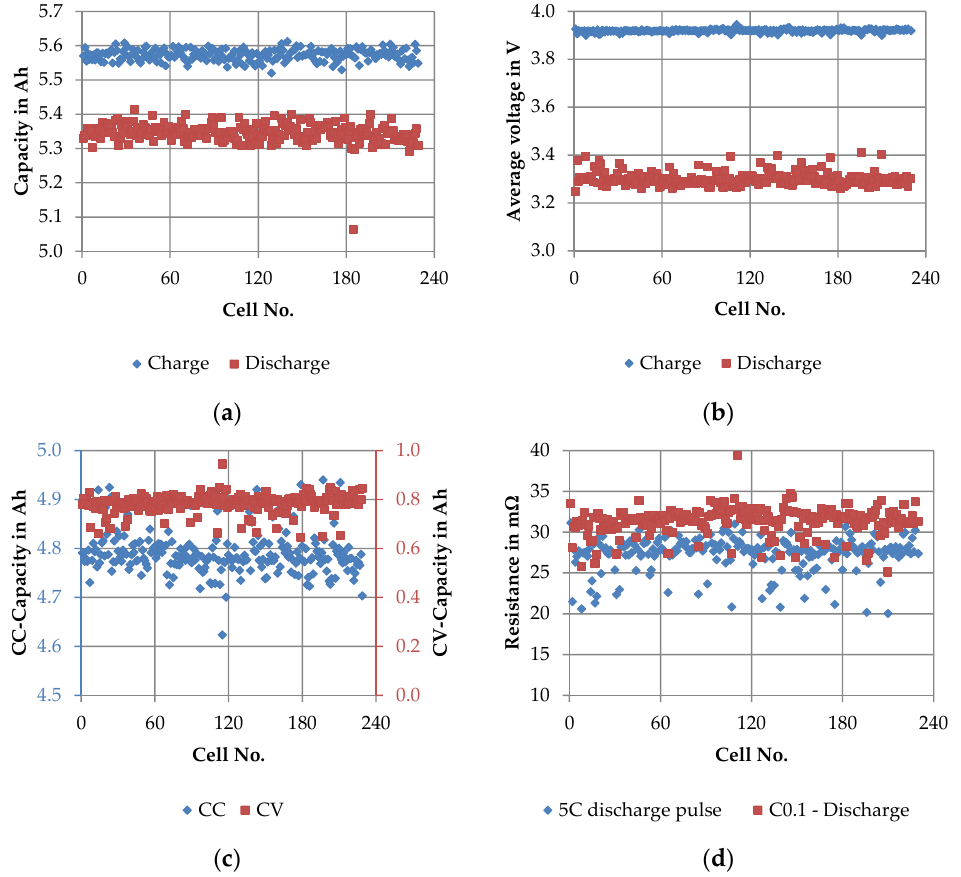
Figure 6. Main results of the short quality test: ( a ) 1C charge capacity vs. 5C discharge capacity, cycle C1; ( b ) average voltage of 1C charging step vs. average voltage of 5C discharging step, cycle C1; ( c ) share of 1C-CC capacity vs. share of 1C-CV capacity, cycle C1 and ( d ) internal resistance from 5C discharge pulse and discharge step of cycle C0.1.